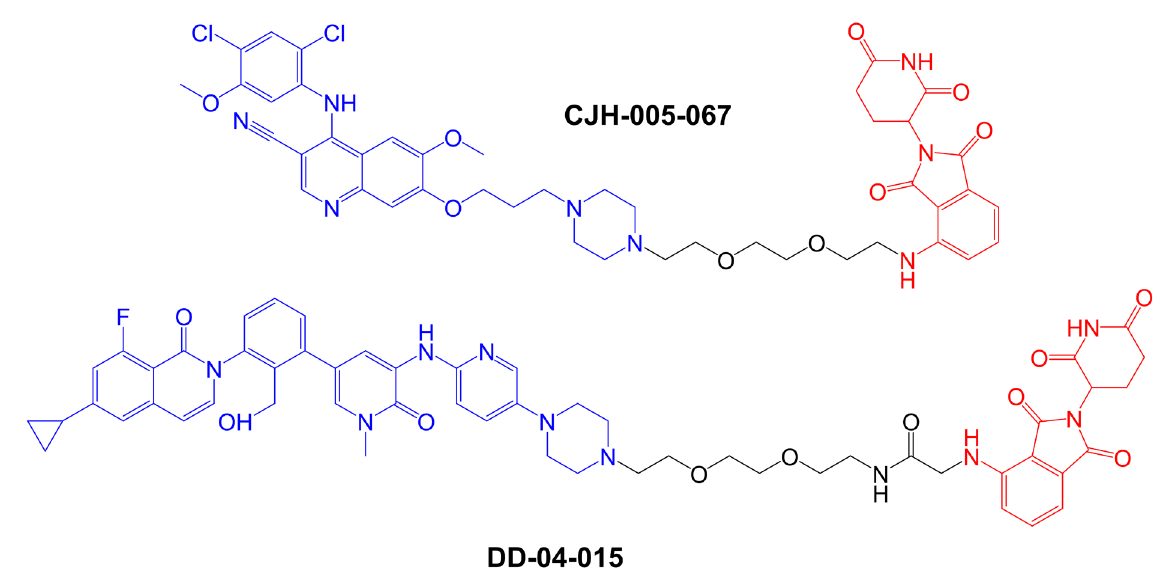
Figure 4. Structures of compounds CJH-005-067 and DD-04-015. BTK-targeted warheads (derived from bosutinib in CJH-005-067 and RN486 in DD-04015) are colored blue and pomalidomide-derived CRBN-targeting moieties are colored red [8